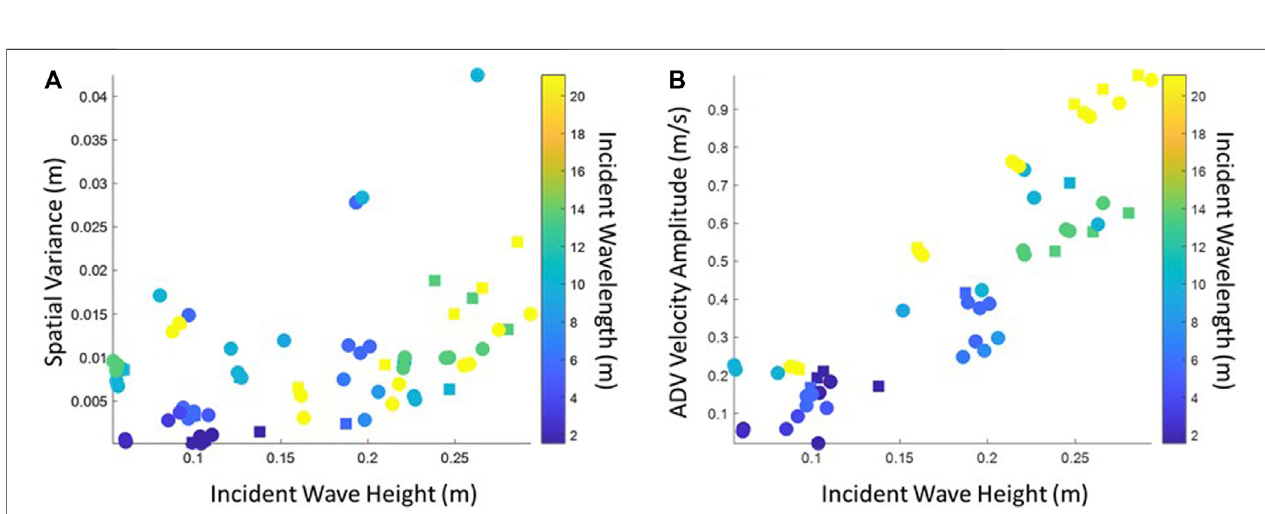
FIGURE8|(A) Thespatialvariance ofwaveheightwithinthematnetworkasmeasured bythepressuregages (y-axis), and (B) waveheight(x-axis)versusvelocity (y-axis) measured before the mats by the ADV. Color shows the associated wavelength with lighter colors indicating longer waves, and darker colors indicating shorter waves.Higherincidentwaveheighttranslatestohigher velocitiesbeforethemats,asexpected,andhigher varianceofpressurewithinthematnetworkindicates greater changes in wave height as the waves penetrate the network.